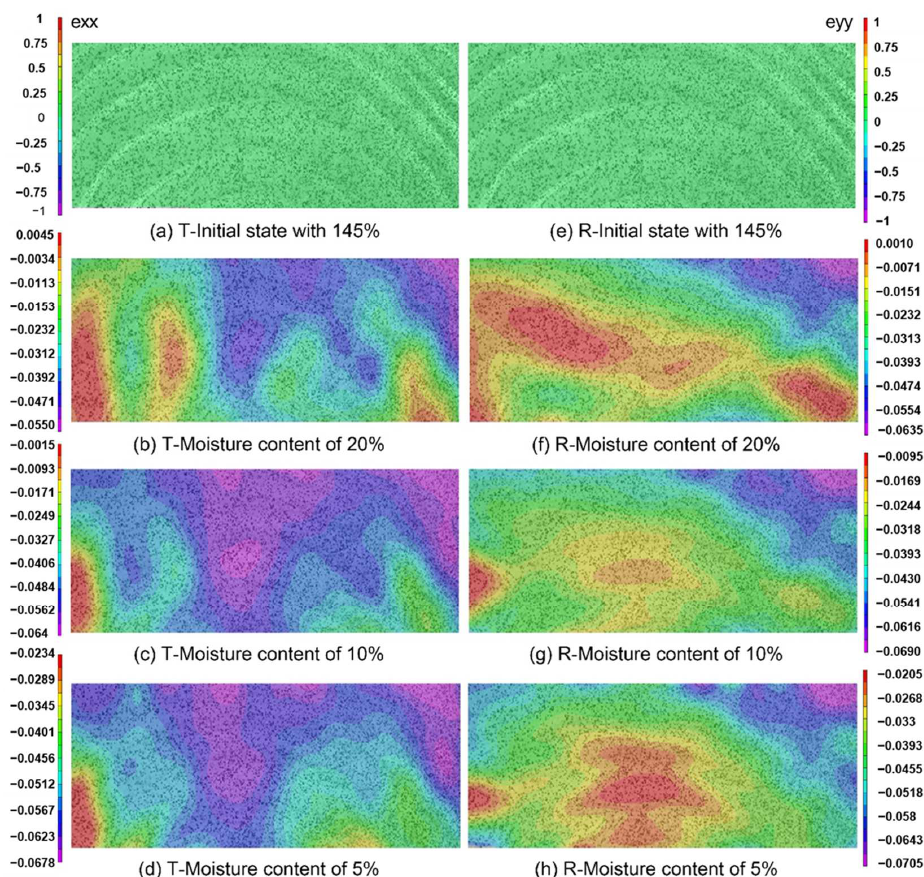
Figure 3. The distribution of tangential ( a – d ) and radial ( e – h ) shrinkage strains at different MC, where exx and eyy denote the strain in tangential and radial directions, respectively. The color bars indicate the amount of shrinkage strain.